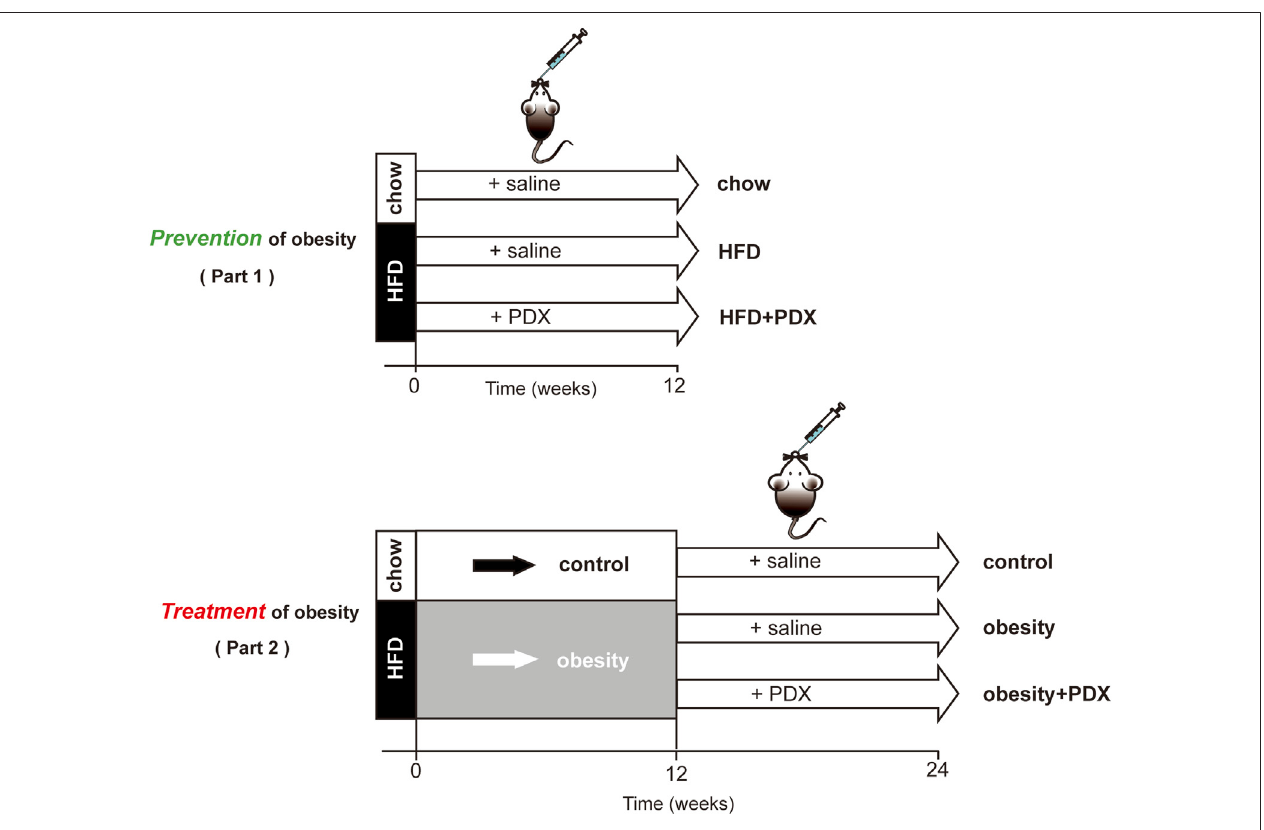
FIGURE 1 | Schematic diagram of the two-part animal experiment